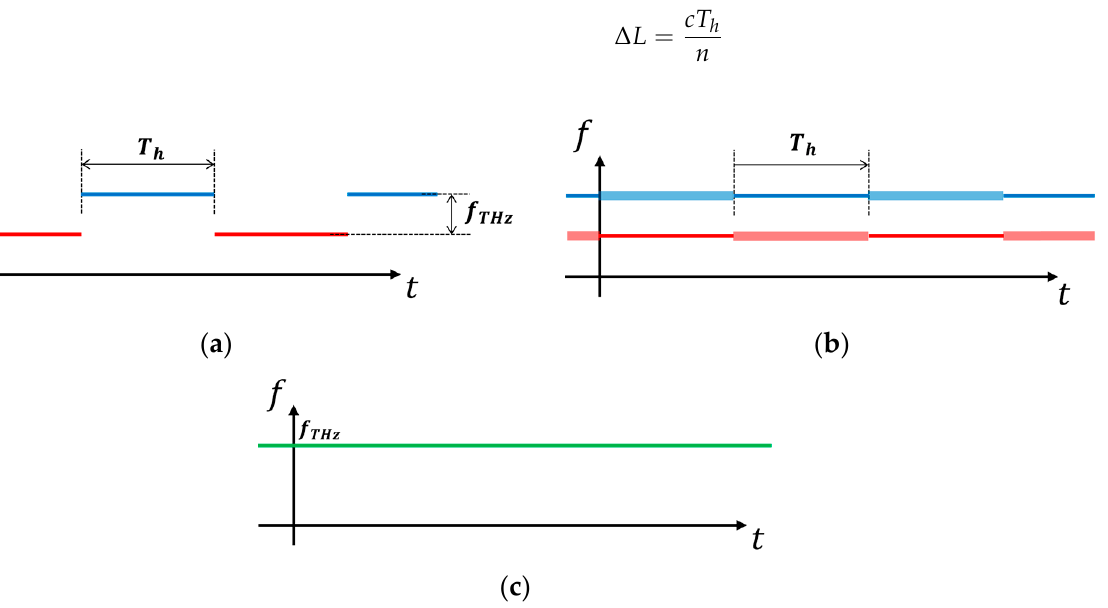
Figure 2. ( a ) The optical frequency of the lightwave from a wavelength-tunable laser at (i) of Figure 1d. ( b ) The optical frequency of the lightwave before photomixing at (ii) of Figure 1d. ( c ) The frequency of the teraher tz wave generated by the photomixer at (iii) of Figure 1d).